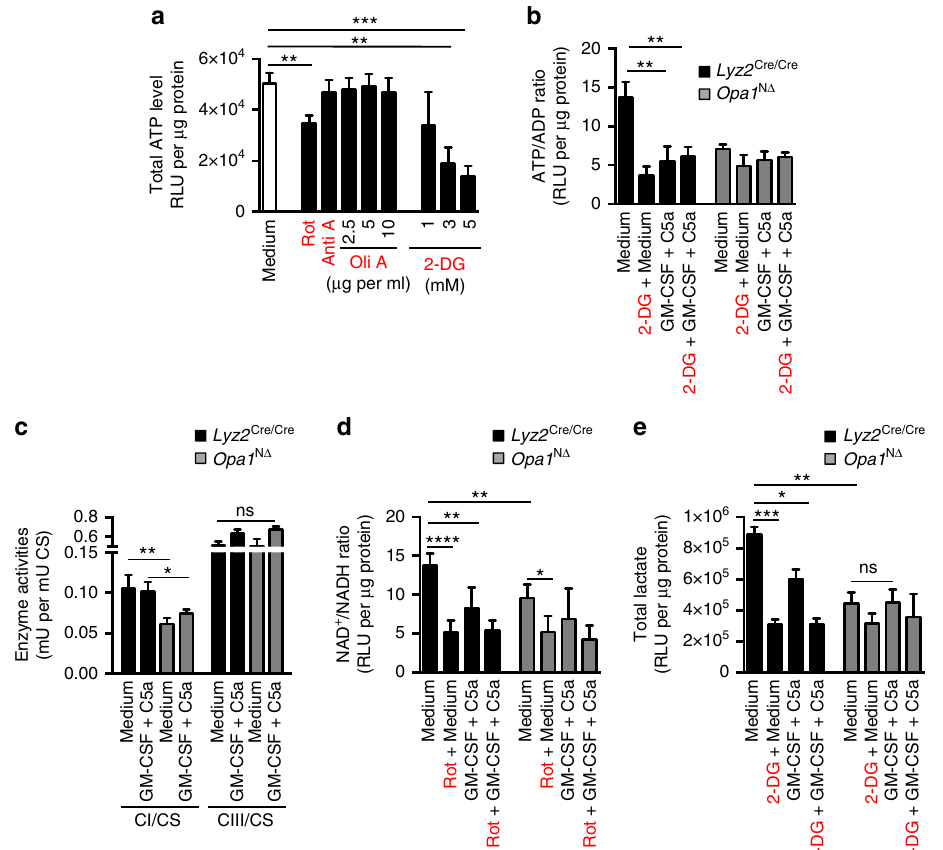
Fig. 5 Reduced glycolytic ATP production in neutrophils of Opa1 N Δ mice is a consequence of reduced mitochondrial complex I activity. a ATP-dependent luciferase activity assay. Control human neutrophils were incubated with the indicated inhibitors for 70 min in a concentration-dependent manner. Relative luciferase unit (RLU) values are means ± SEM. ** p < 0.01; *** p < 0.001; n = 3. b ATP/ADP bioluminescent assay. Neutrophils of Opa1 N Δ and control mice were pre-treated with 3 mM 2-DG for 70 min and the ATP/ADP ratio was measured in the presence and absence of GM-CSF/C5a. RLU values are means ± SEM. ** p < 0.01; n = 6. c Complex I (CI), complex III (CIII) and citrate synthase (CS) activities of mitochondria isolated from resting and GM-CSF/ C5a-activated Opa1 N Δ and control Hoxb8 neutrophils were assessed in the presence and absence of 10 µ M rotenone (Rot) using a spectrophotometer. Values are means± SEM. n.s., not signi fi cant; * p < 0.05; ** p < 0.01; n = 3. d NAD/NADH bioluminescent assay. NAD + /NADH ratios in resting and GM- CSF/C5a-activated neutrophils of Opa1 N Δ and control mice were measured after 70 min incubation in the presence and absence of 10 µ M Rot using a NAD/NADH determination kit. RLU values are means ± SEM. * p < 0.05; ** p < 0.01; **** p < 0.0001; n = 5. e Lactate bioluminescent assay. Lactate levels in resting and GM-CSF/C5a activated neutrophils of Opa1 N Δ and control mice were measured after 70 min incubation in the presence and absence of 3 mM 2-DG using a lactate determination kit. RLU values are means ± SEM. n.s., not signi fi cant; * p < 0.05; ** p < 0.01; *** p < 0.001; n = 4. ECAR and OCR data are provided in Supplementary Fig.